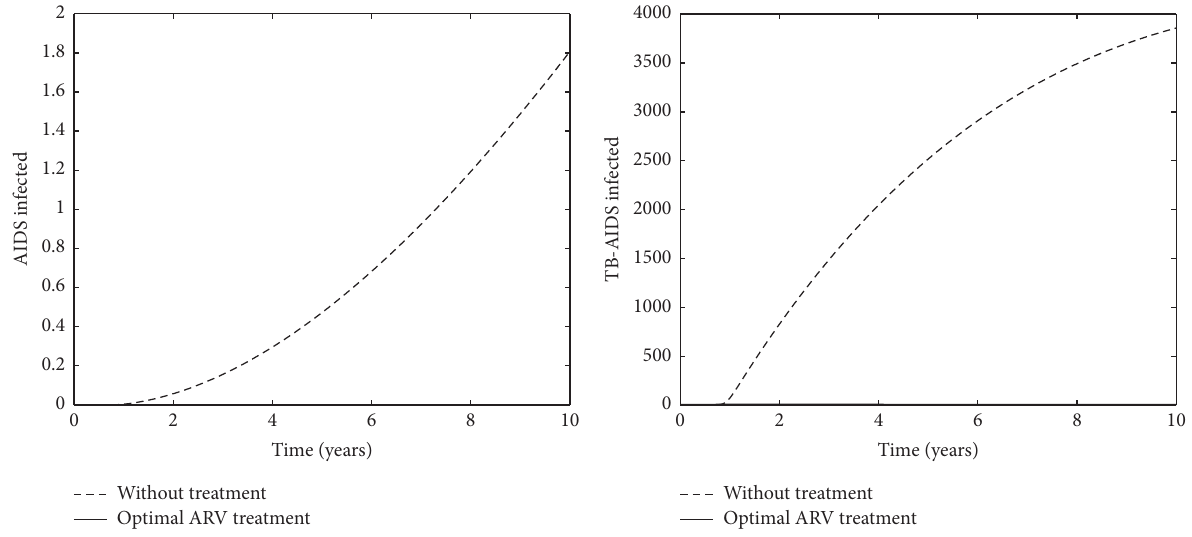
Figure 11: The dynamics of 𝐴 ℎ and 𝐴 ℎ𝑡 using control 𝑢 ∗ 2 .